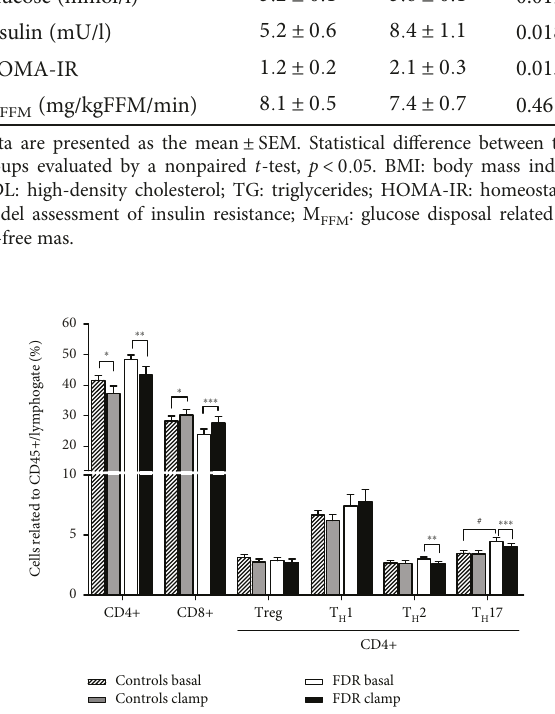
Figure 1: E ff ect of hyperinsulinemia on lymphocyte populations in the blood in FDR and in control subjects. Lymphocyte populations are expressed as the percentage of positive cells related to CD45/lymphogate. ∗∗∗ p < 0 001 . ∗∗ p < 0 01 . ∗ p < 0 05 , signi fi cant change during the euglycemic-hyperinsulinemic clamp. $ p < 0 05 , signi fi cant di ff erence between FDR and in control subjects at baseline. Striped bars: baseline preclamp levels in controls. Grey bars: postclamp levels at the end (2 hours) of the clamp in controls. White bars: baseline preclamp levels in FDR. Black bars: postclamp levels at the end (2 hours) of the clamp in FDR. FDR: fi rst-degree